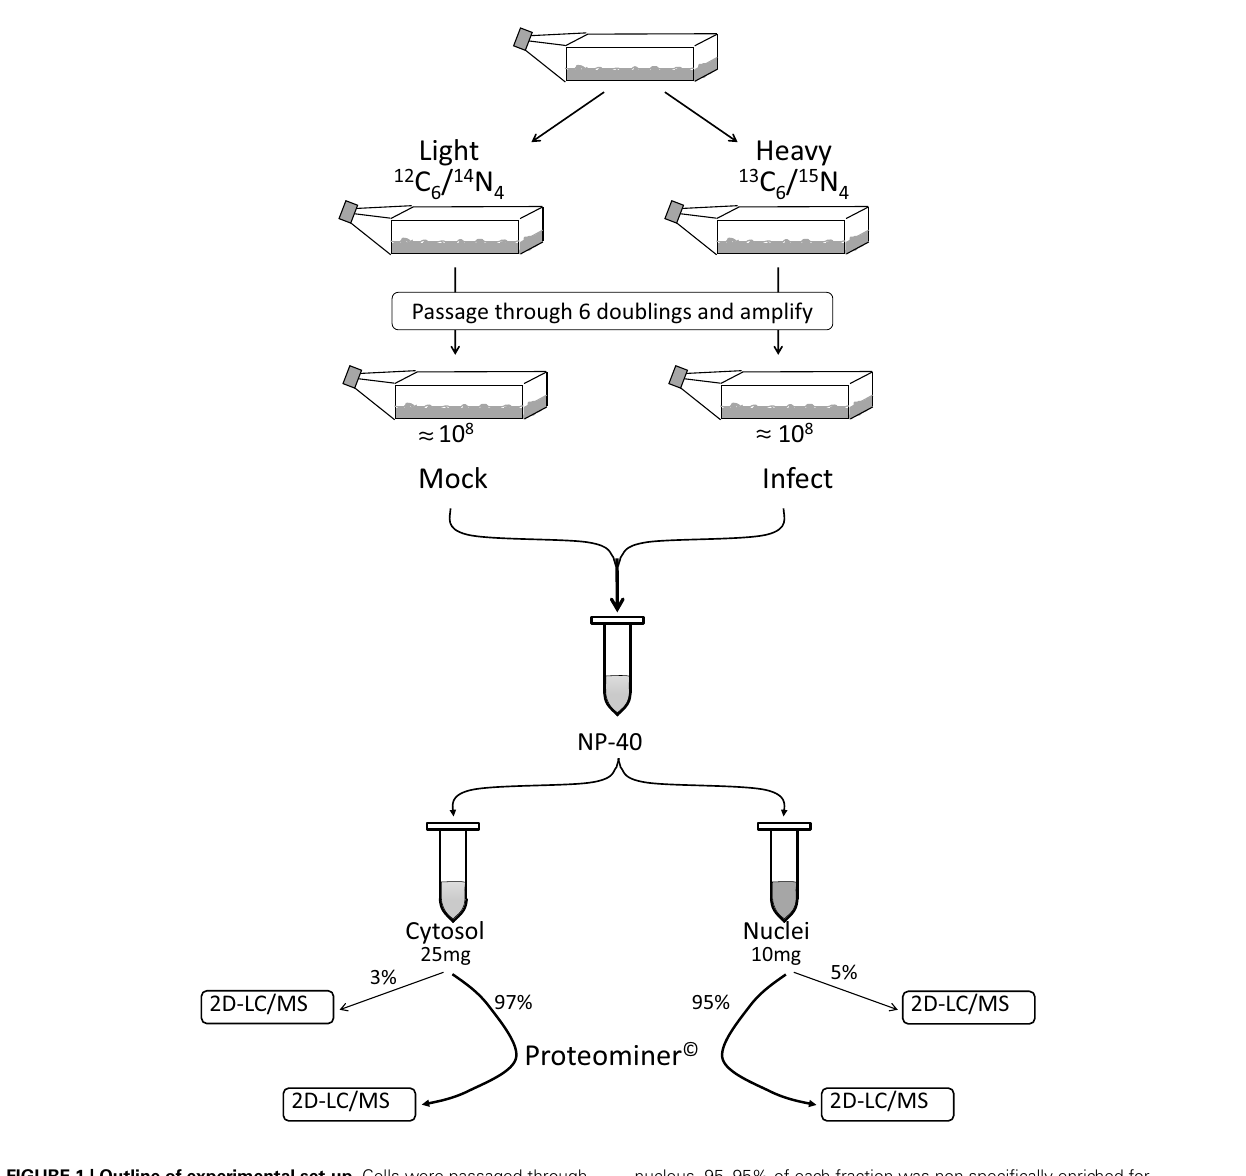
FIGURE 1 | Outline of experimental set-up. Cells were passaged through six doublings in either L ight or H eavy SILAC medium and the H cells infected with reovirusT3D. Infected ( H ) and mock-infected ( L ) cells were mixed together 1:1. After the cells were washed and lysed to separate cytosol from